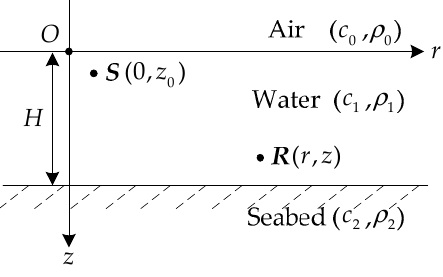
Figure 1. Isovelocity uniform layered media model.